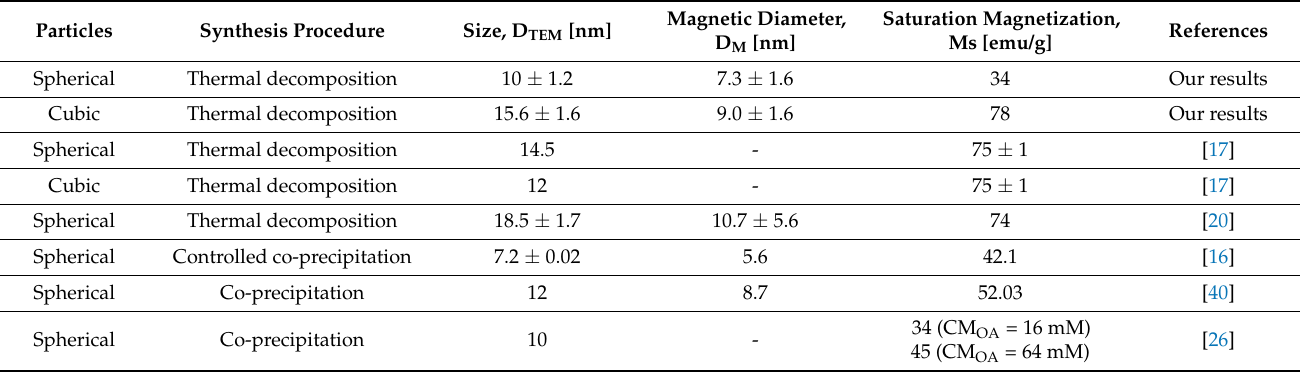
Figure 8. ( A ) Sphere- and cubic-shaped nanoparticle magnetization curves at room temperature (300 K). ( B ) Inset to ( A ): detail of the hysteresis loop. ( C ) Initial magnetization curve. Magnetic diameter is calculated from these curves. Table 4. Magnetization saturation of the synthesized MNPs and comparison with published values.